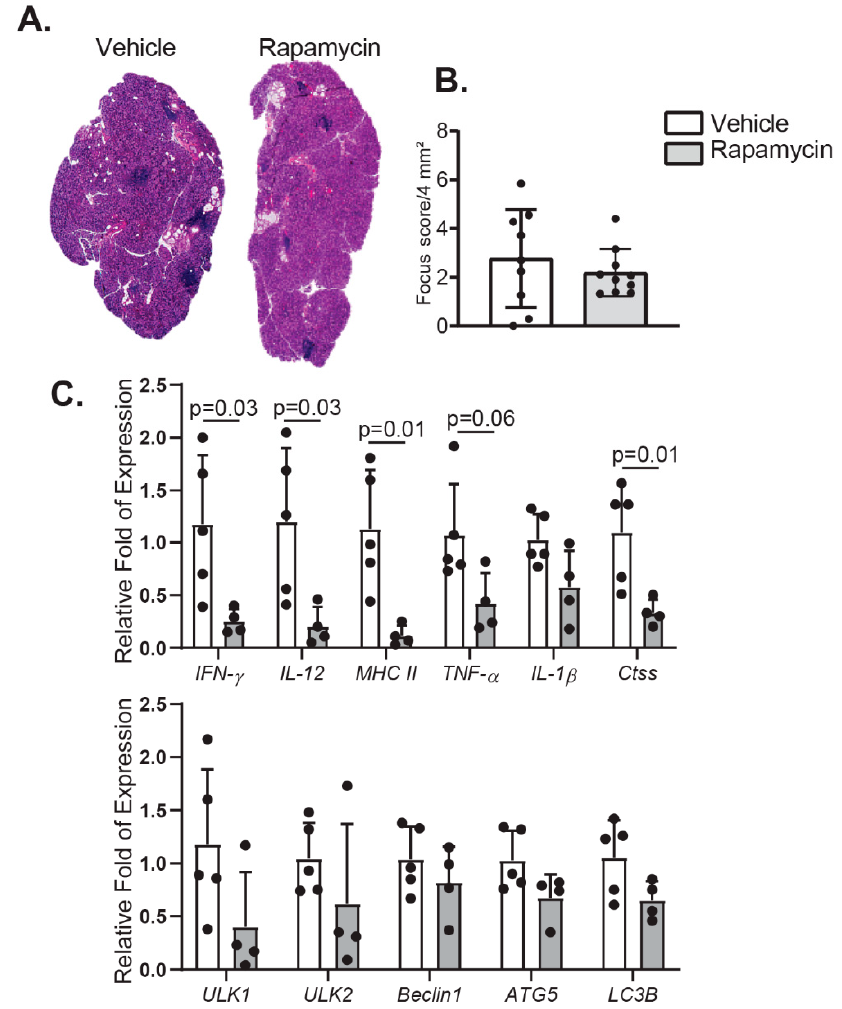
Figure 3. Degree of inflammation and autophagy in the lacrimal gland of the aged mice treated with rapamycin eyedrops. ( A ) Representative images of H&E stained histologic sections of lacrimal gland from aged mice instilled either with vehicle or rapamycin eyedrops, used to generate the graphs on B. ( B ) Focus score in the lacrimal gland was also calculated ( n = 9–10 / group, Mann–Whitney test). ( C ) Relative mRNA fold expression of either pro-inflammatory or autophagy markers in lacrimal glands were quantified by qPCR ( n = 4–5 / group, each dot represents one animal; error bars indicate the standard deviation (SD) of the mean, Mann–Whitney test).